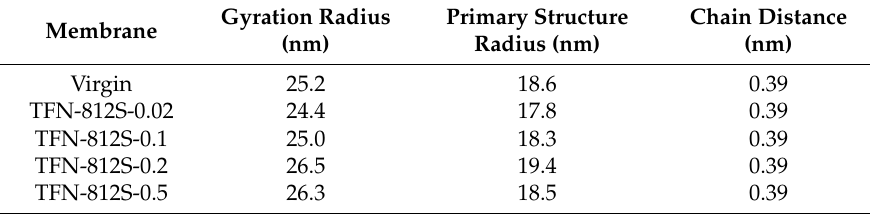
Table 3. SAXS comparison of membranes with di ff erent concentrations of R812S